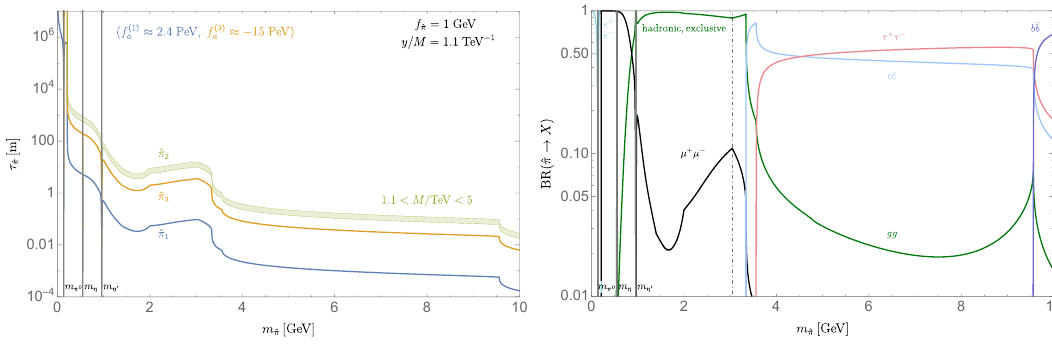
Figure 3 . Lifetimes (left) and branching ratios (right) of the dark pions for e Y = 0 . In the left panel we have fixed y/M to saturate the Z → invisible bound and f = 1 GeV . In the right panel only ˆ π selected decay channels are shown; see figure 1 for the complete picture. The vertical dot-dashed line indicates the value of m where our description of ALP decays transitions from exclusive hadronic ˆ π final states to perturbative